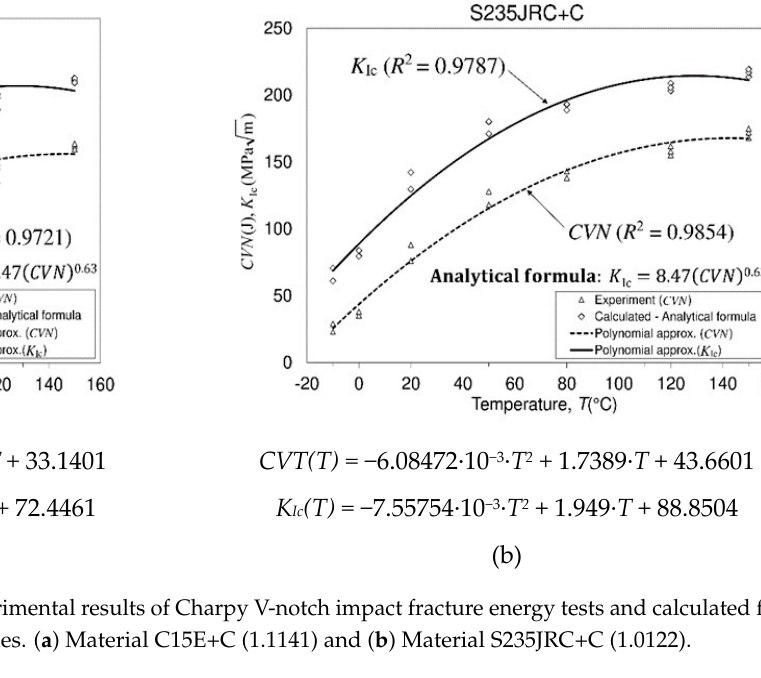
Figure 2. Experimental results of Charpy V-notch impact fracture energy tests and calculated fracture toughness values. ( a ) Material C15E + C (1.1141) and ( b ) Material S235JRC+C (1.0122)